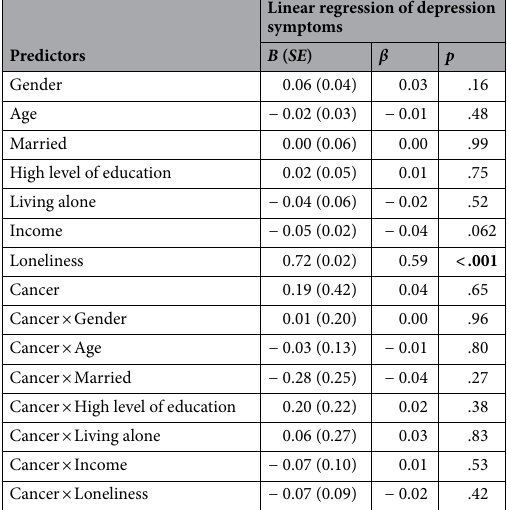
Table 2. Multiple linear regression of depression symptoms (PHQ-2). Adjusted R 2 = 0.35. Significant values are in bold.